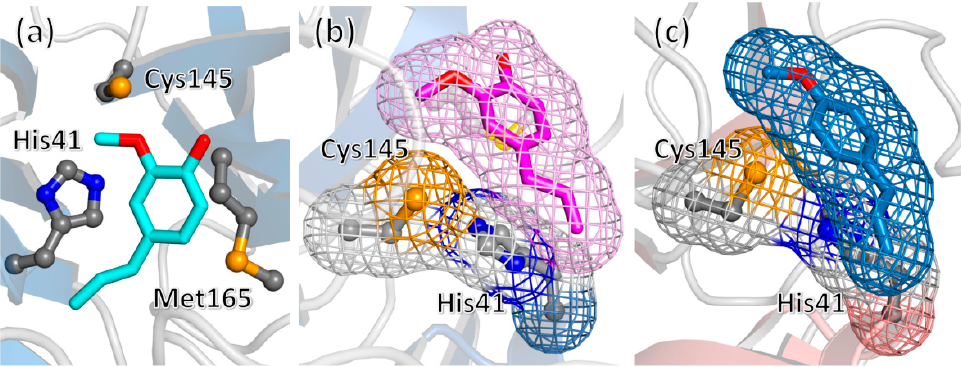
Figure 5. ( a ) Docking pose (binding energy of –5.7 kcal/mol) of eugenol in the active site of 3CLpro (protein extracted from PDB structure 7DPU), interacting with the protein side chains of the catalytic dyad His41/Cys145 and with residue Met165. ( b ) Similar binding mode obtained for another 3CLpro structure (entry 6YNQ), shown in a different orientation to highlight the interaction of the propanoid tail with residue His41. ( c ) One of the binding modes of estragole to unliganded 3CLpro (protein from PDB entry 6Y2E).